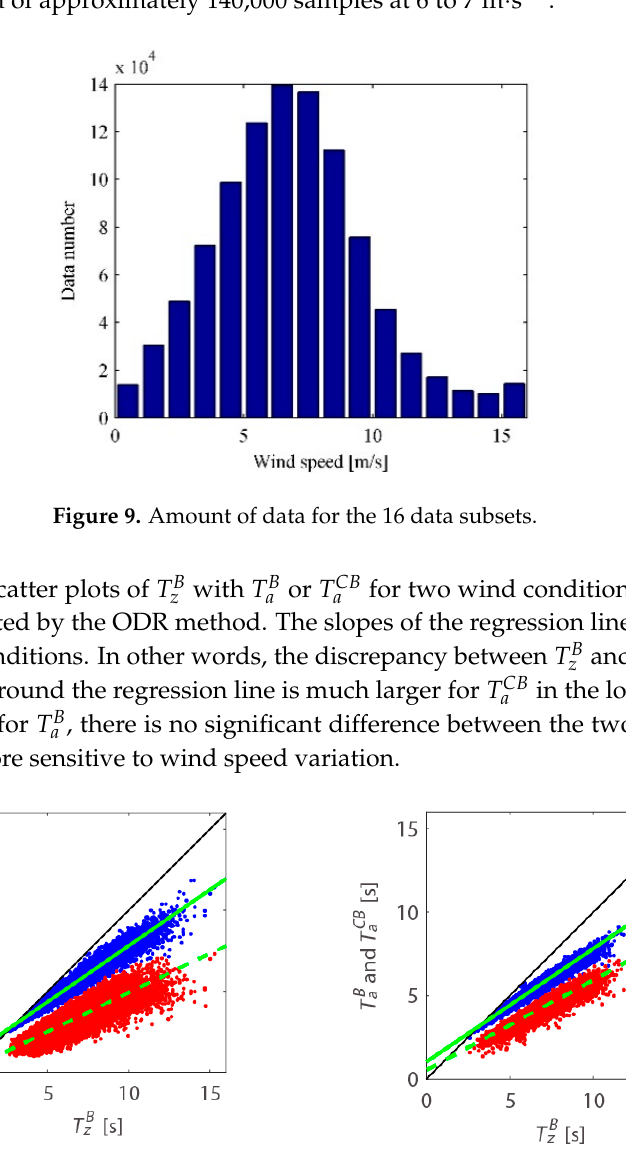
Figure 10. Scatter plot of T B z with T B a (blue) or T CB a (red), together with regression lines (solid and broken lines, respectively). For subsets ( a ) wind speed: 4–5 m · s − 1 and ( b ) wind speed: 10–11 m · s − 1 .